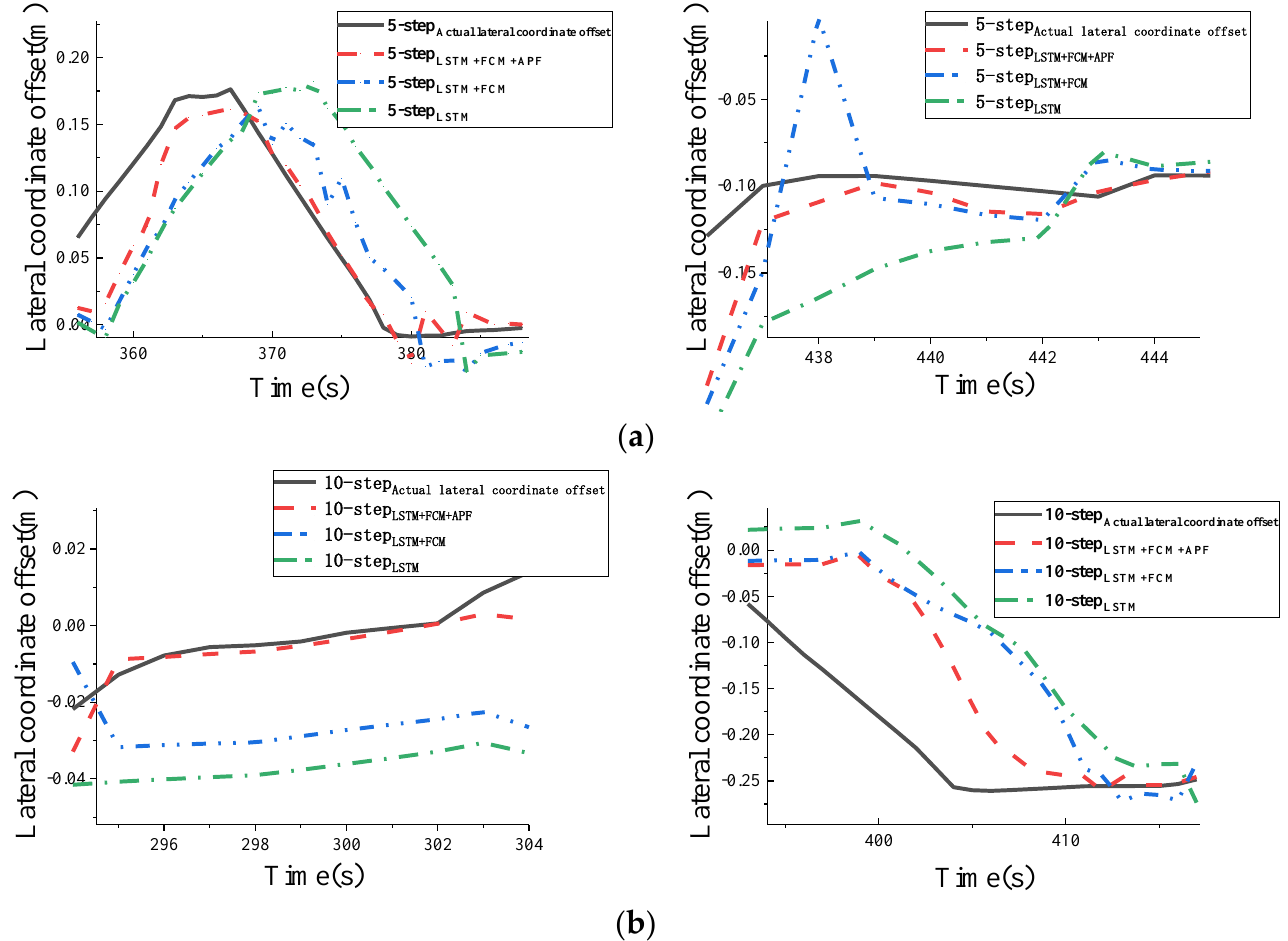
Figure 5. Lateral coordinate prediction results: ( a ) lateral coordinate 5 − step prediction results and ( b ) lateral coordinate 10 − step prediction results.